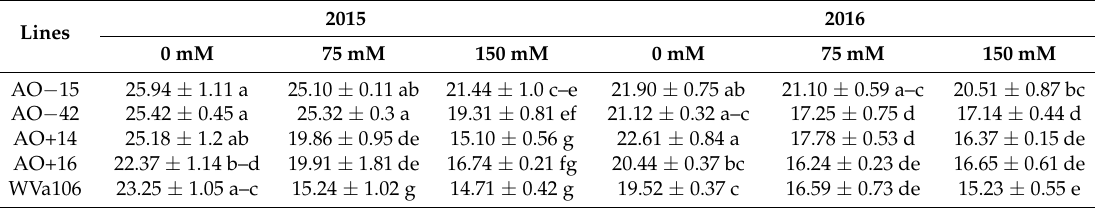
Figure 4. The effect of three salinity levels 0 mM (black bars), 75 mM (speckled bars), and 150 mM NaCl (striped bars) on ascorbic acid content of red-ripe fruit of cherry tomato lines. ( A ) Ascorbic acid (mg 100 g − 1 FW) in 2015 and ( B ) ascorbic acid (mg 100 g – 1 FW) in 2016. Results with the same superscript were not significantly different ( p < 0.05) according to the classification obtained by the Duncan test. Table 2. Lycopene content ( µ g g − 1 FW) of lines with low or elevated AO activity, and non-transgenic line of red-ripe cherry tomato fruits under two salinity levels (75 and 150 mM NaCl) in 2015 and 2016. Results with the same letter were not significantly different ( p < 0.05) according to the classification obtained by the Duncan test.